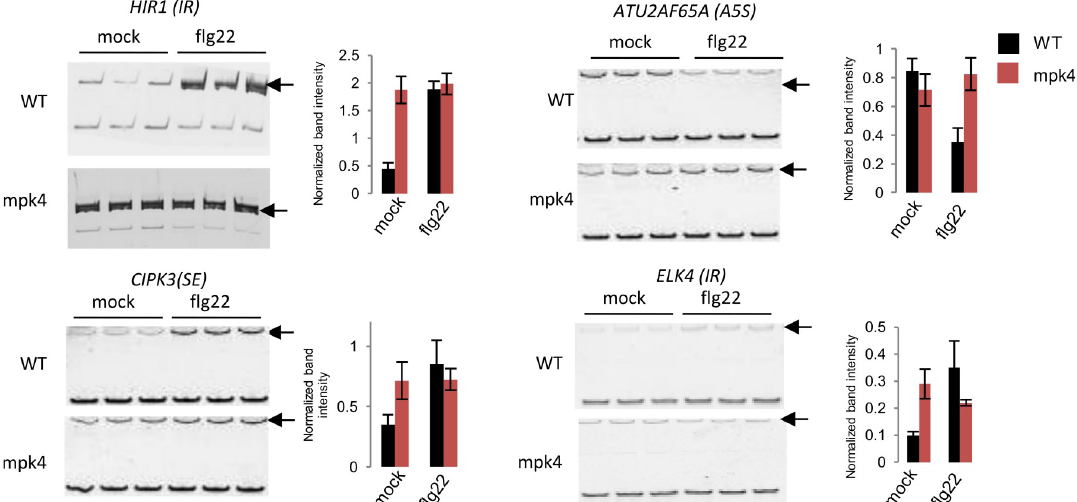
Fig 4. RT-PCR analysis of selected differential splicing events in mpk4 and WT in mock- or flg22-treated plants. RT-PCR was performed on 3 biological replicates and products were separated on the same gel. A black arrow marks the position of the alternative isoforms. Band intensity was normalized against the non-differential isoforms. Significant differences were calculated by t-test ( � : p- value < 0.05).